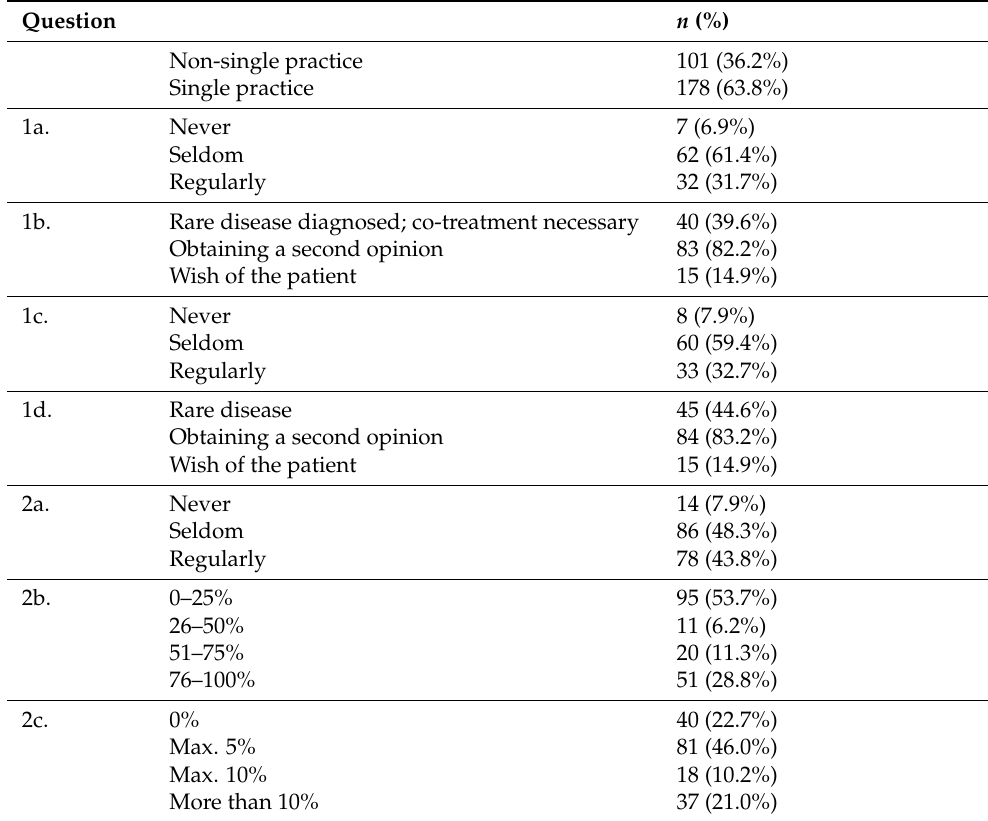
Table 3. Questions on professional cooperation in the field of rare diseases with orofacial participation (Section